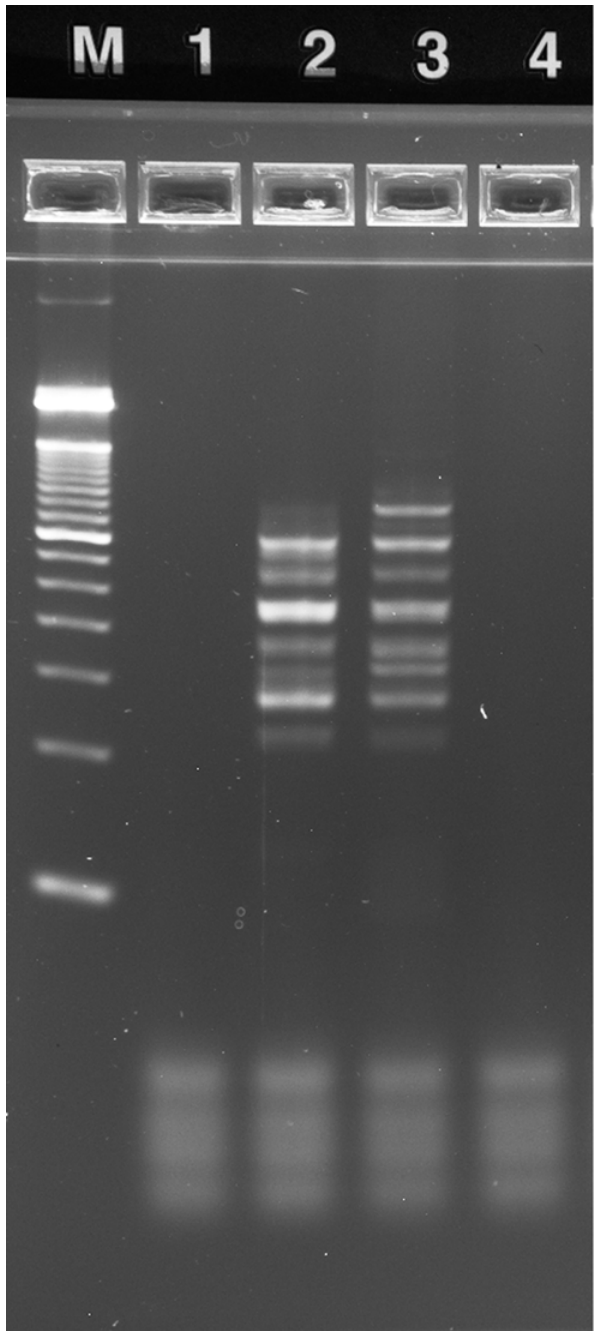
Fig 13. E-Gel image showing PowerPlex 16 HS amplification results. Lanes (M) 50 bp ladder, (1) Bench- top NTC, (2) Bench-top positive control 2800M template, (3) rzPCR positive control 2800M template, (4) rzPCR